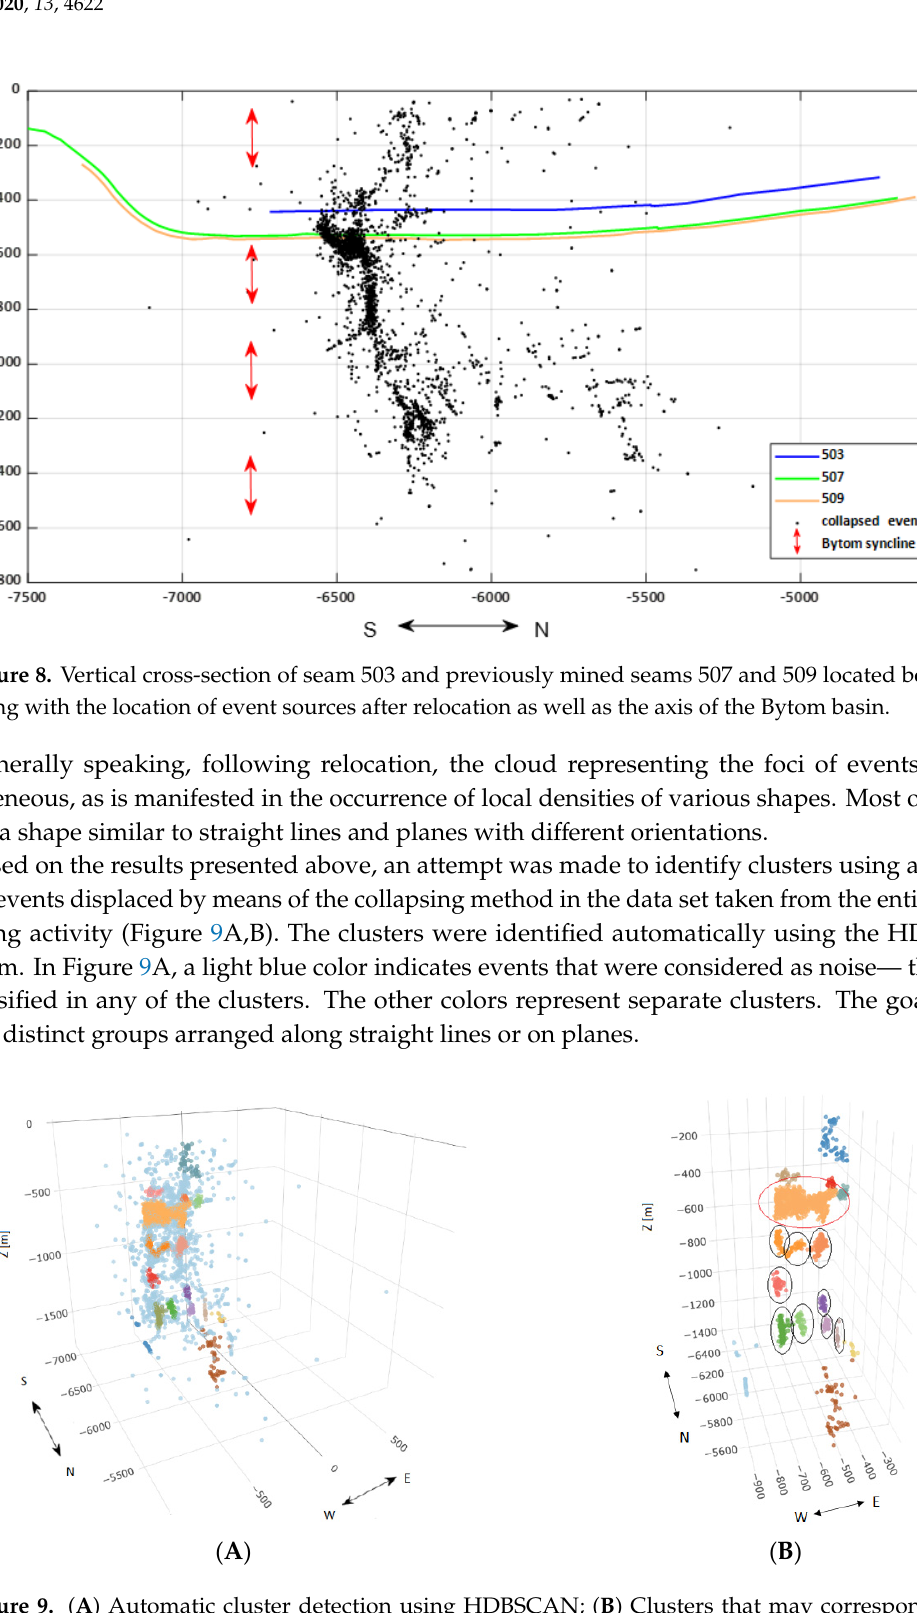
Figure 9. ( A ) Automatic cluster detection using HDBSCAN; ( B ) Clusters that may correspond to tectonic structures (marked with a black ellipse) and directly related to mining activity (marked with a red ellipse).